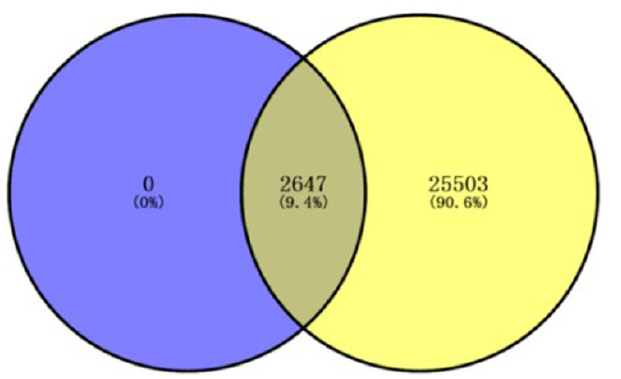
Figure 1. Venn plot of genes potentially involved in genistein’s action against human cervical cancer. The purple color represents the targets of genistein, and the yellow color represents the genes related to the progression of human cervical